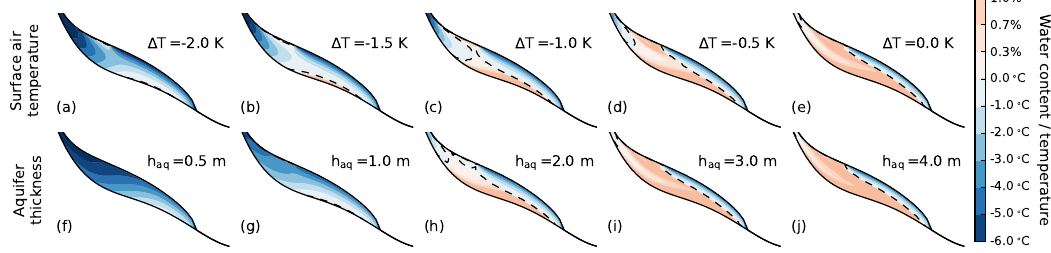
Fig. 7. Examples of polythermal structure types in the model results. In the upper row (a–e), surface air temperature ( ∆ T ) is varied. In the lower row (f–j), near-surface aquifer thickness ( h aq ) is varied. Each panel represents a steady-state. Dashed line indicates the cold-temperate transition.